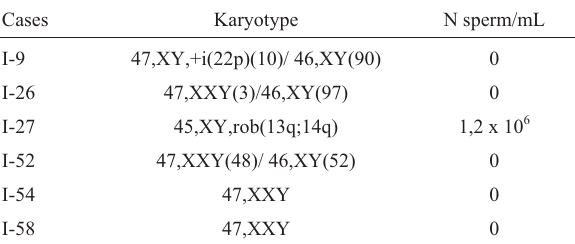
Table 1 - Karyotype abnormalities detected in 65 infertile men.